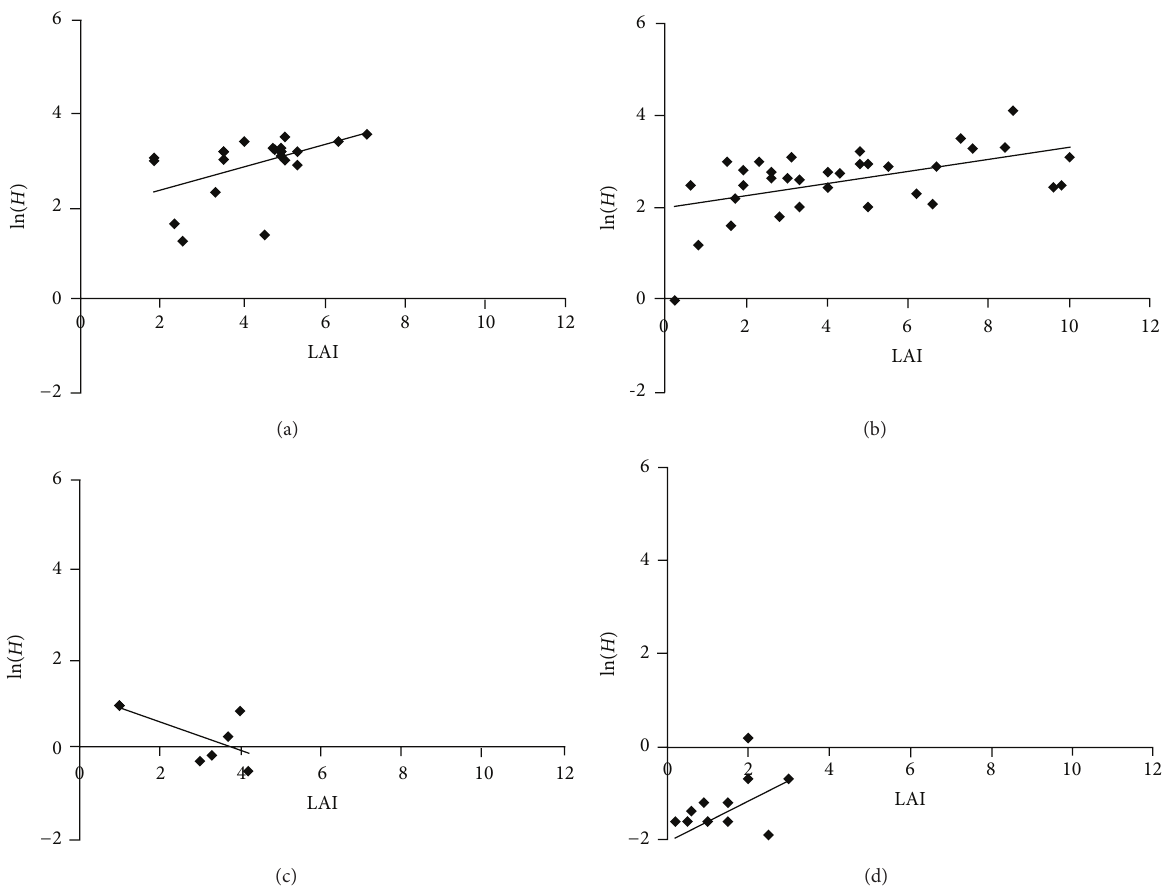
Figure 1, the five site-years in the yellow circle, which do not have the coordinate information, are from the second version (Version 2) database of the Global Land Cover